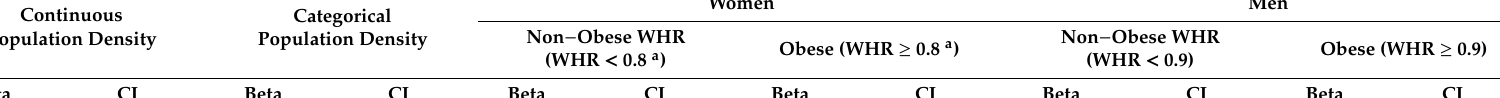
Table 2. Standardized estimates of the e ff ects of built environment elements on waist–hip ratio (WHR) and heterogeneous e ff ects across sex and weight